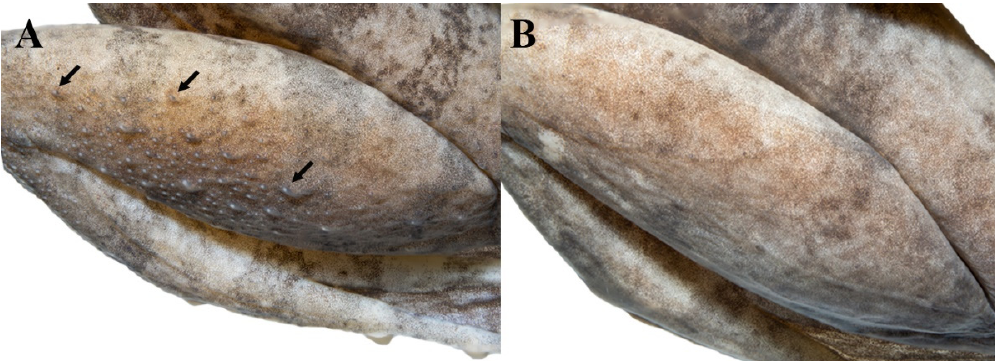
Figure 13. Comparison of dorsal surfaces of the shank showing tubercles (arrows) in adult males of ( A ) the holotype of Limnonectes pseudodoriae sp. nov . (ZMKU AM 01567), and ( B ) L. doriae (ZMKU AM 01546) from Mok Champae District, Mueang Mae Hong Son District, Mae Hong Son Province, Thailand.